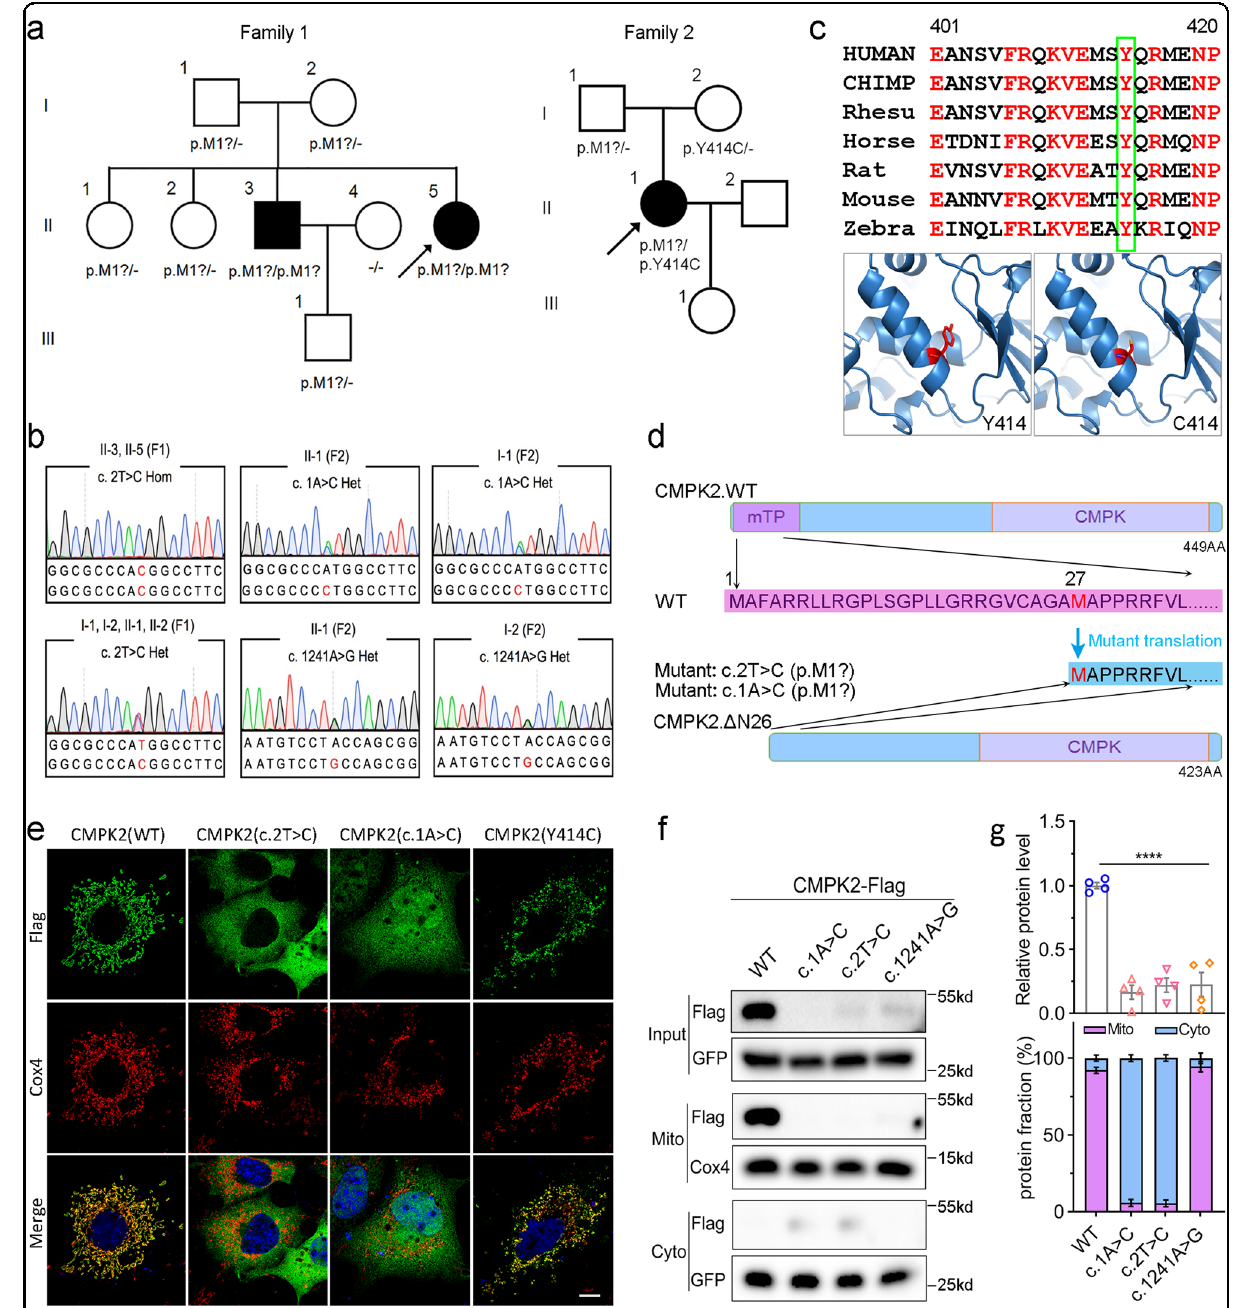
Fig. 1 CMPK2 variants in FBC patients. a The pedigrees of the brain calci fi cation families (Family 1 and Family 2) with CMPK2 variants. Filled or empty symbols represent individuals with or without brain calci fi cation. “ + / − ” indicates heterozygous variant carriers, “ − / − ” indicates individuals without this variant. The arrows represent the probands. b Sequencing chromatograms showing CMPK2 c.2 T > C in Family 1, and CMPK2 c.1 A > C and c.1241 A > G in Family 2, with the reference allele below. The variants are marked in red. het heterozygous, hom homozygous. c Homologous alignment of the CMPK2 protein sequence bearing the core domain α 7b helix that includes p.Y414, and the protein conformation change of Y414C. d A schematic diagram of the initiation codon loss of CMPK2 . CMPK2 (c.1 A > C p.M1?; c.2 T > C, p.M1?) mRNA transcription could perhaps be re- initiated from a subsequent ATG codon (p.M27), leading to loss of the mTP in the CMPK2 protein ( △ N26). mTP mitochondrial targeting peptide sequence, CMPK CMP-UMP kinase domain. e Immuno fl uorescence analysis of subcellular localization of the CMPK2 protein. Cos-7 cells were transfected with Flag-tagged CMPK2 wild-type (WT), c.1 A > C, c.2 T > C, and c.1241 A > G mutant plasmids, and immune-stained with antibodies against Flag (green) and the mitochondria marker COX IV (red). DAPI (blue) was used for nuclear staining. Scale bar, 5 μ m. f Western blot analysis for the mitochondrial and cytoplastic expression of CMPK2. Primary cultured rat neurons were transfected with Flag-tagged CMPK2-WT, c.1 A > C, c.2 T > C, and c.1241 A > G plasmids. The CMPK2 protein quantitative statistics by Image J were displayed in g , **** P <